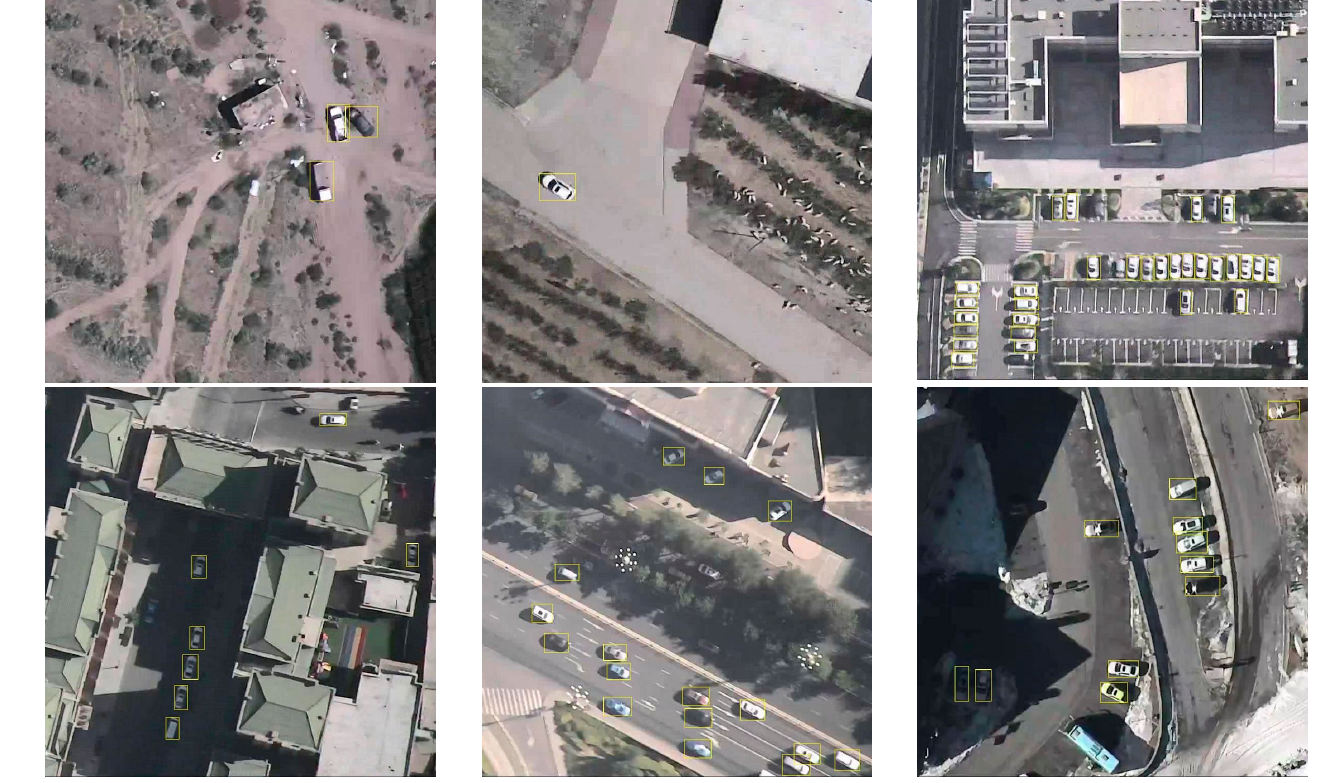
Figure 7. Examples in VHRAI.